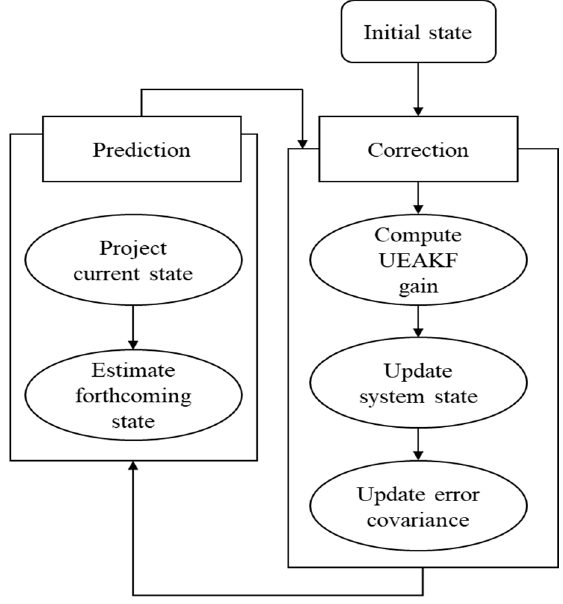
Figure 4. Block diagram of